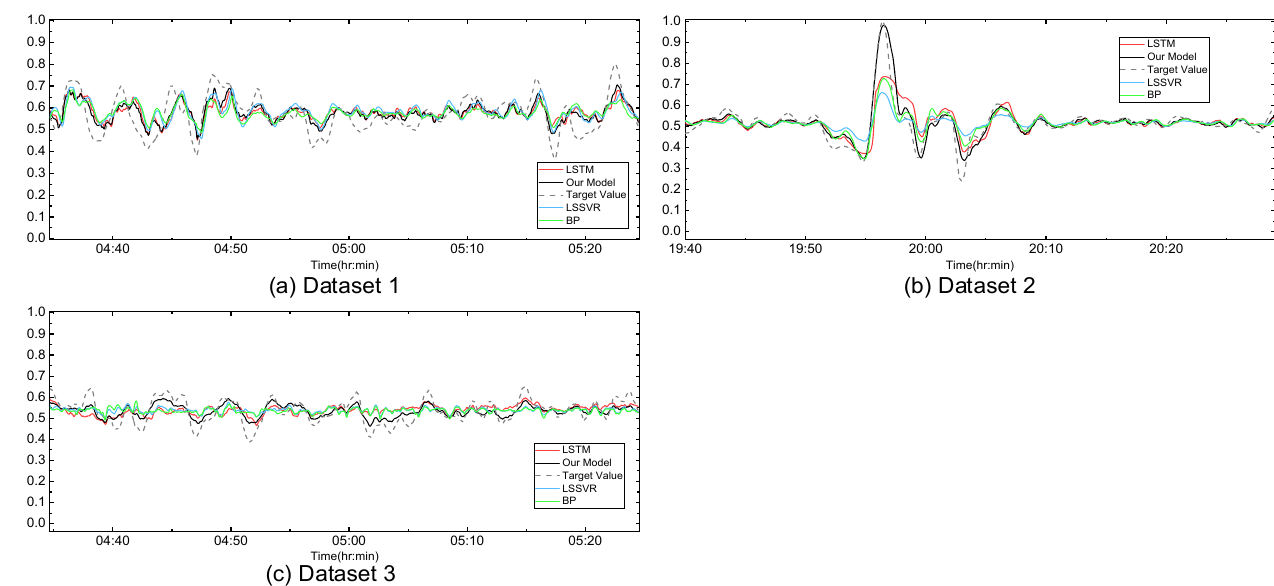
Figure 15. The prediction comparison diagram of differential value.